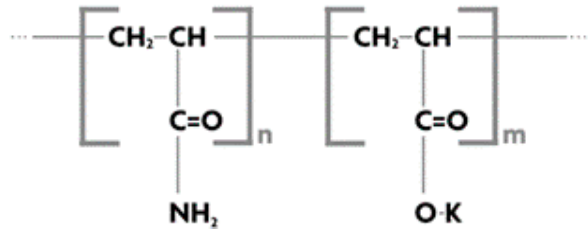
Figure 9. Structure of Aquasorb.